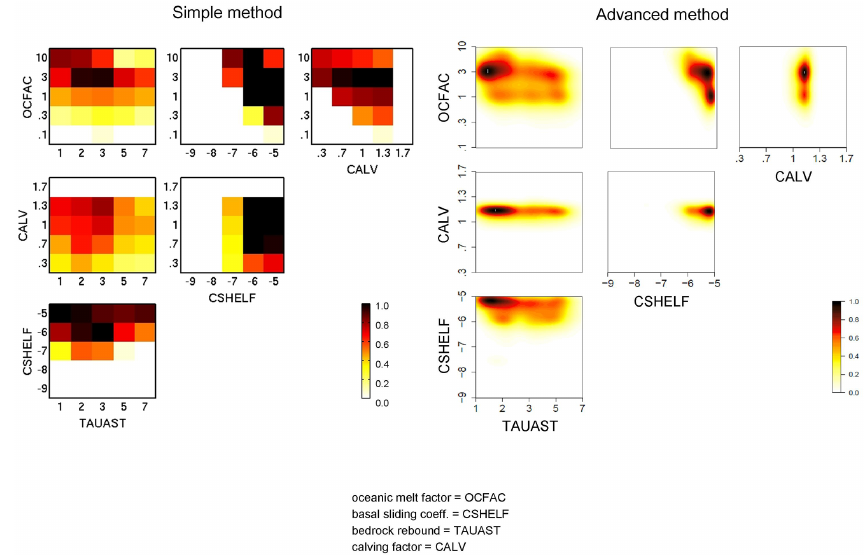
Figure 4. (Left) Ensemble-mean scores for pairs of parameters, using the simple averaging method. (Right) Probability densities for pairs of parameters, using the advanced statistical techniques in Chang et al. (2016) extended as described in Sect.